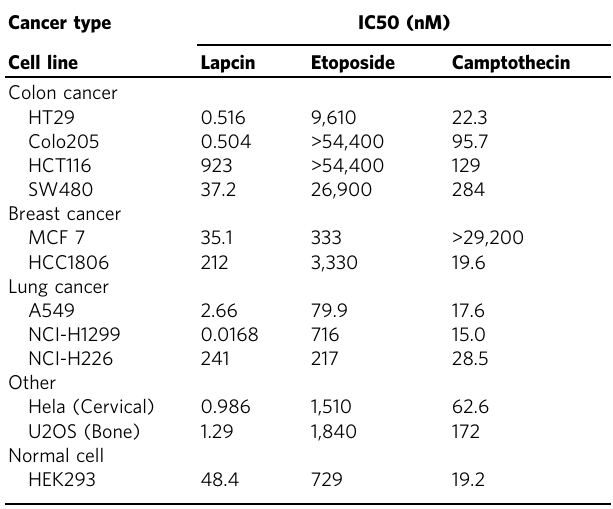
Table 1 Lapcin activity against human cell